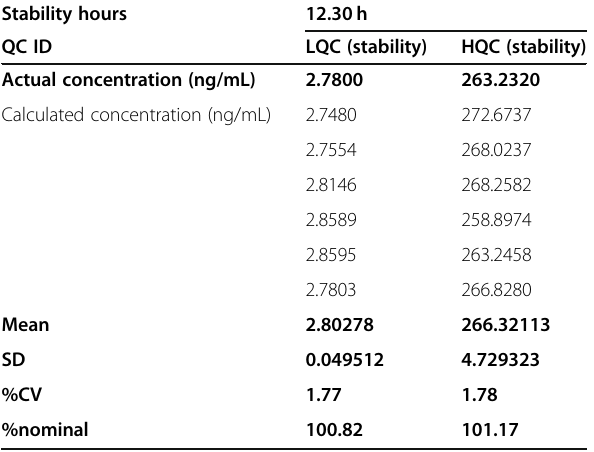
Table 14 Bench top stability for bexarotene Table 15 Auto sampler stability for